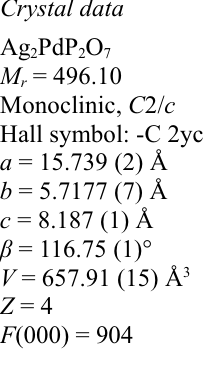
Figure 2 Diphosphato-palladate(II) ribbon [Pd(P Disilver(I) palladium(II) diphosphate Crystal